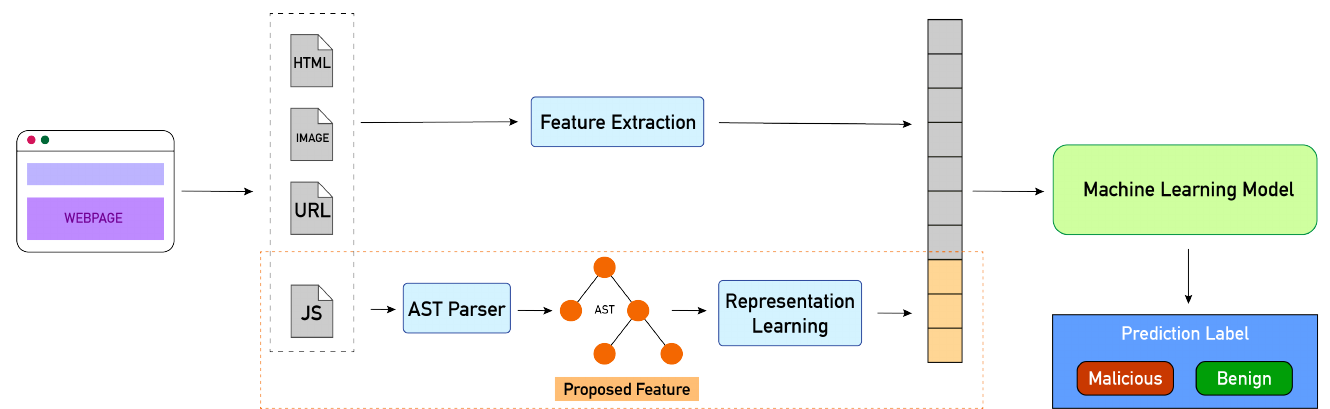
Figure 3. Overview of the proposed